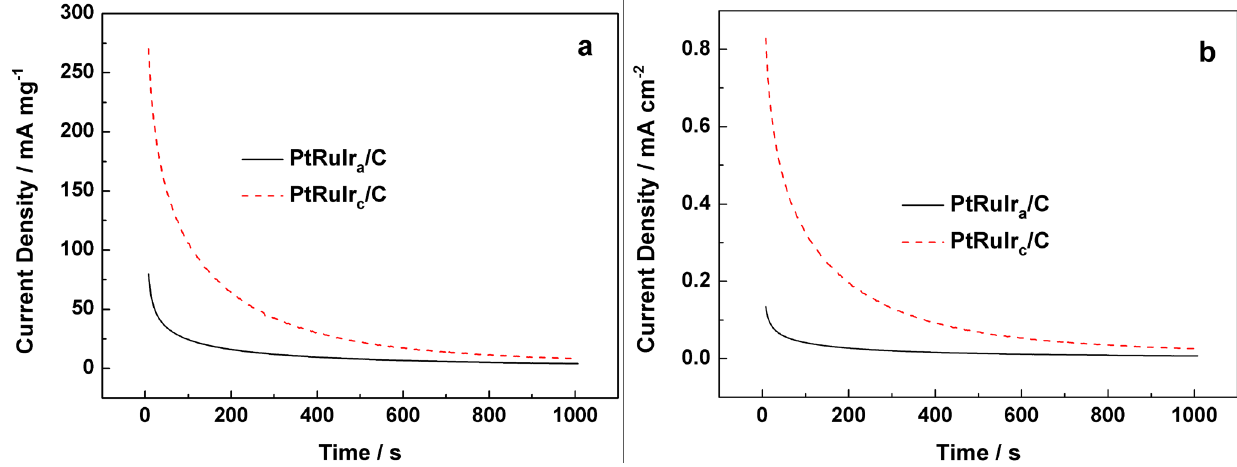
Figure 6. Chronoamper ometry curves of PtRuIr oxidation, polarized at a constant potential of 0.6 V vs . Ag/AgCl at room